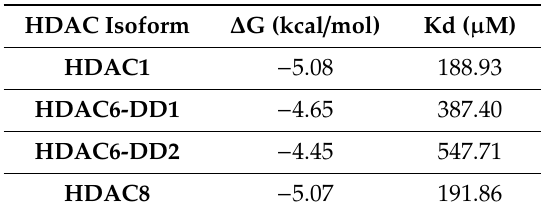
Table 1. Binding free energy ( ∆ G) and theoretical Kd values, predicted from the interaction of HO-AAVPA with HDAC1, HDAC6, and HDAC8 by molecular docking analyses.